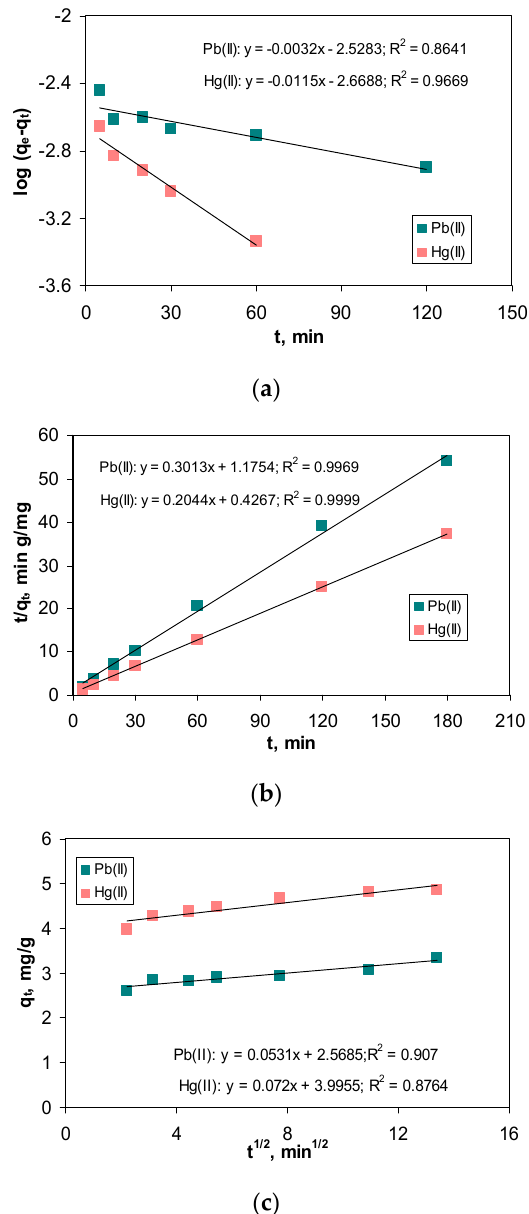
Figure 6. Linear representations of the pseudo-first order model ( a ), pseudo-second order model ( b ) and intra-particle diffusion model ( c ) for the biosorption of Pb(II) and Hg(II) ions onto RWB.